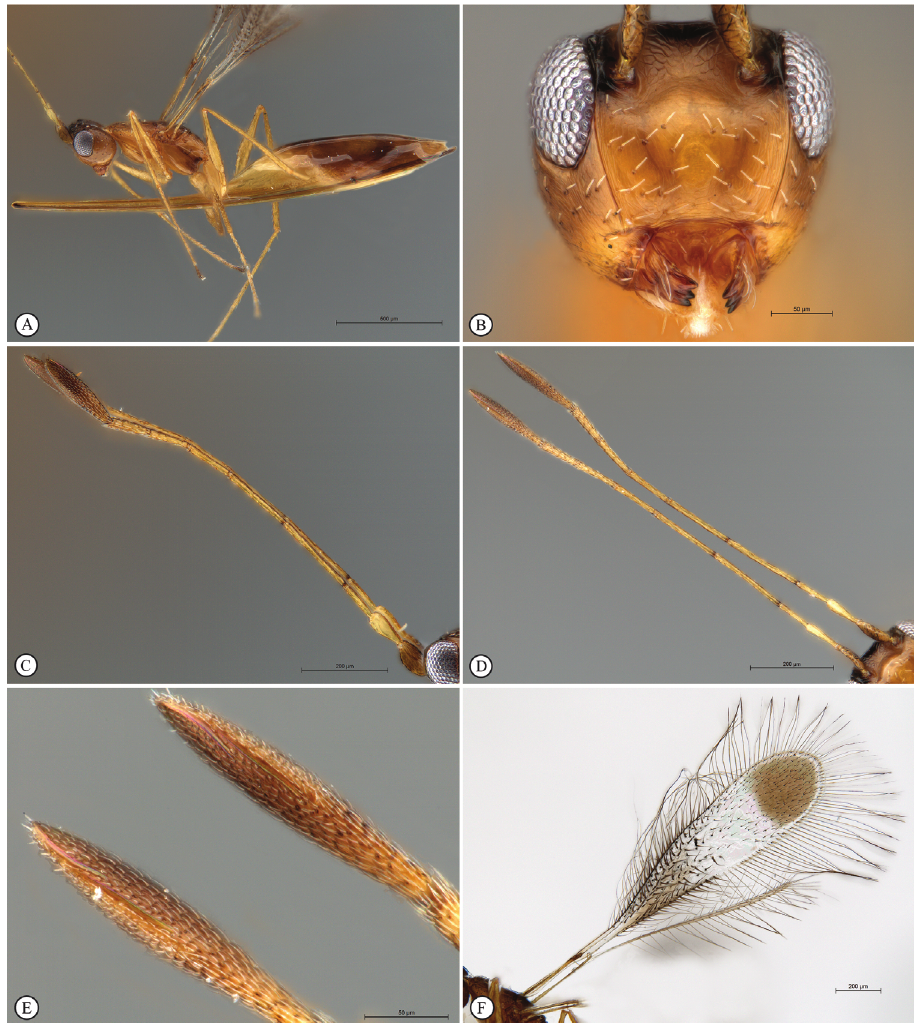
Figure 2. Polynema sagittaria Holotype female. A Body, lateral view B Head, anterior view C Antennae, lateral view D Antennae, dorsal view E Antennal clavae, dorsal view F Wings, dorsal